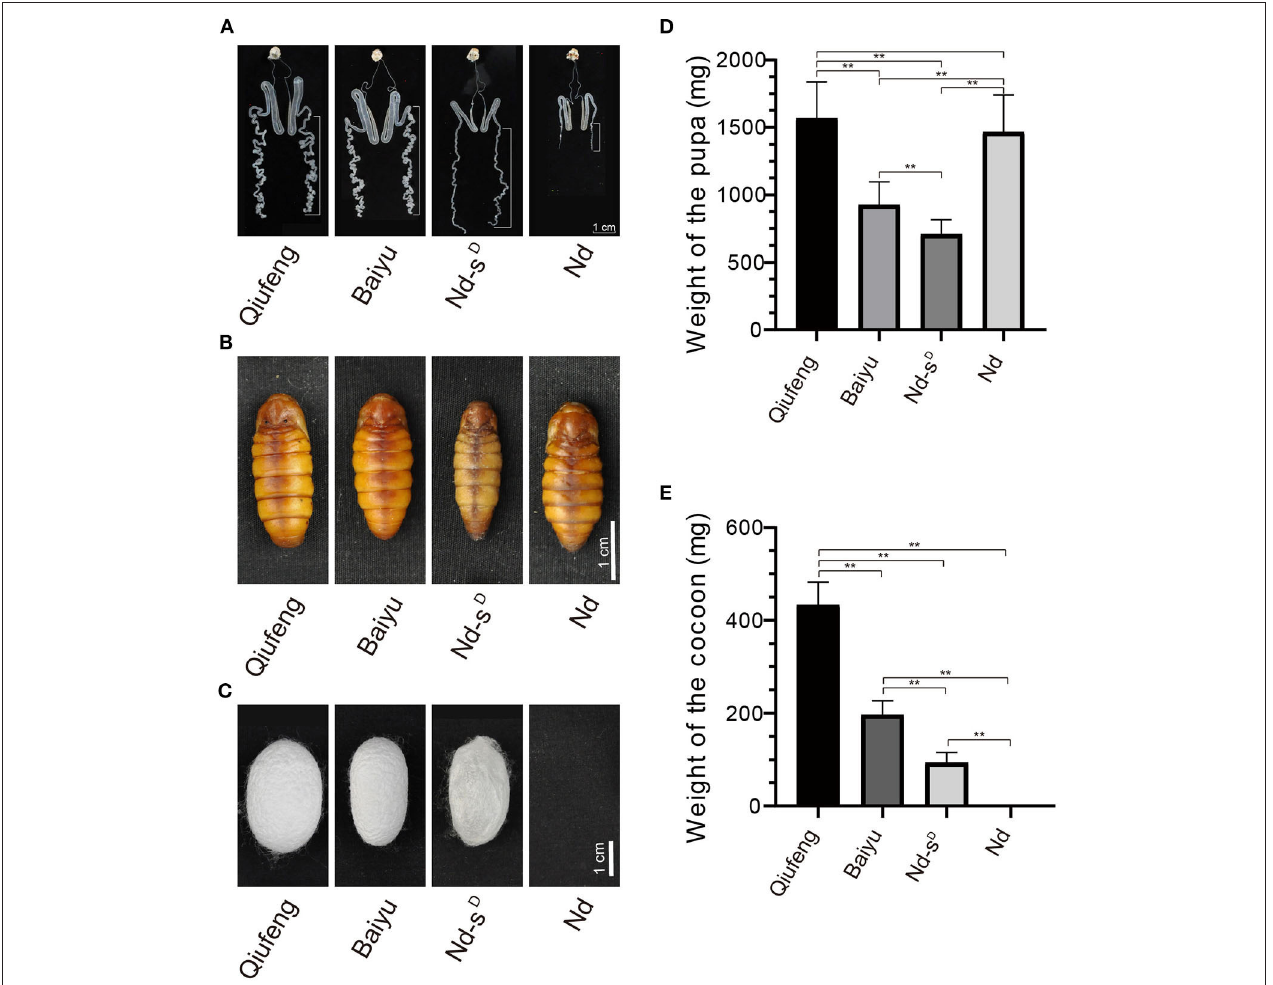
FIGURE 1 | Comparison of Qiufeng, Baiyu, Nd-s D and Nd. The dissected silk glands of silkworms at I5D3. The white long scale bars mark the PSG (A) . The pupa of Qiufeng, Baiyu, Nd-s D and Nd from left to right (B) . The cocoon of Qiufeng, Baiyu, Nd-s D and Nd from left to right (C) . Comparison of the weight of the pupa (D) and cocoon shell (E) of Qiufeng, Baiyu, Nd-s D and Nd. Sixteen pupae and cocoons were collected for each species including eight males and eight females, and Student’s t -test was performed to analyze their pupa and cocoon shell weight differentials. ** P < 0.01. Scale bars, 1cm in (A–C) .